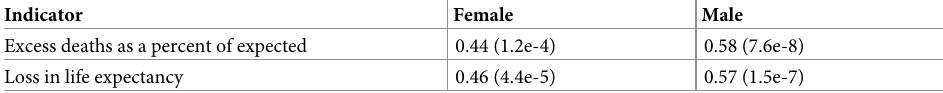
Table 5. Correlation (Pearson r with p-values) of expected life expectancy with 2 indicators, all regions of Russia, 2020. Indicator Female Excess deaths as a percent of